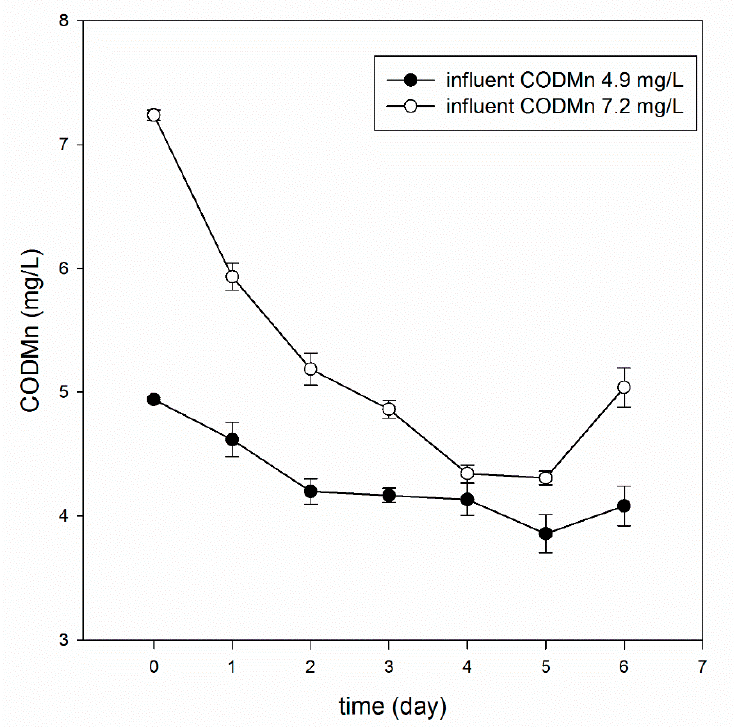
Figure 8. Removal of COD Mn under different influent concentrations.